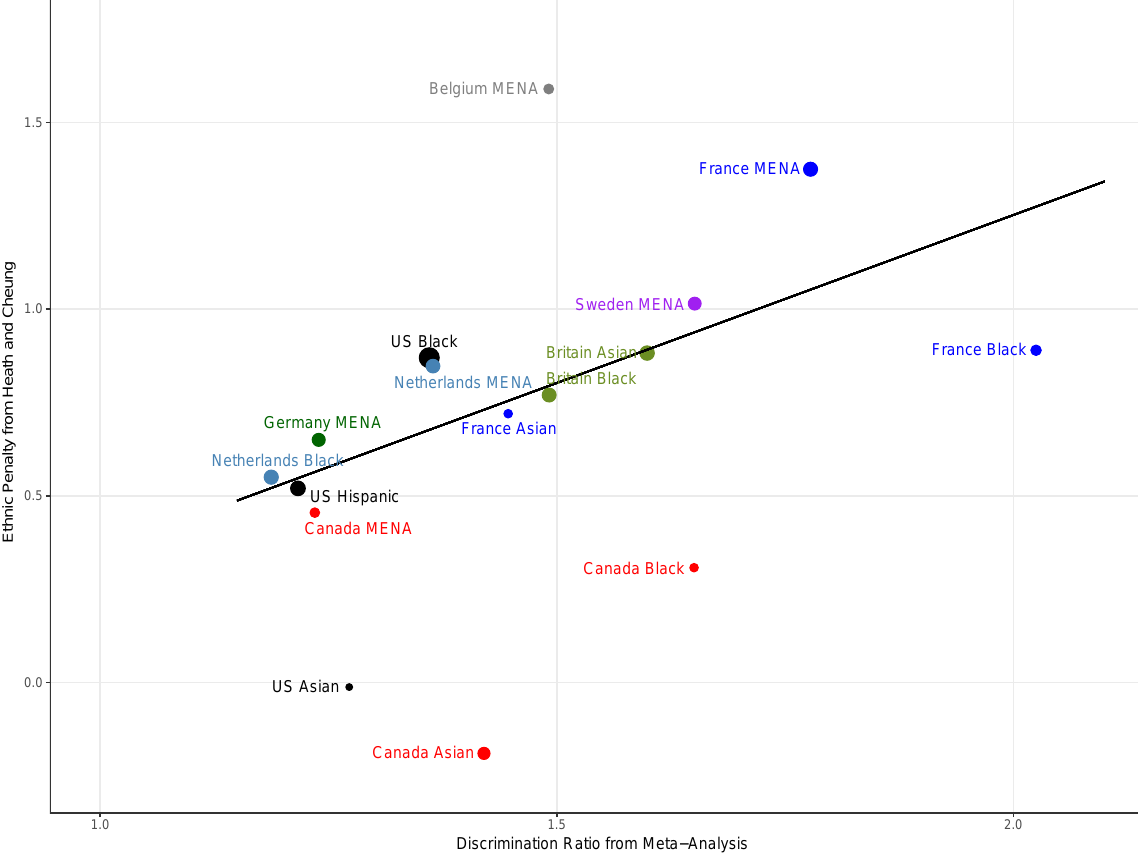
Figure 4: Ethnic penalty and discrimination by country and target group. The size of the symbol is propor- tional to meta-analysis weight. Country and minority group are indicated next to the